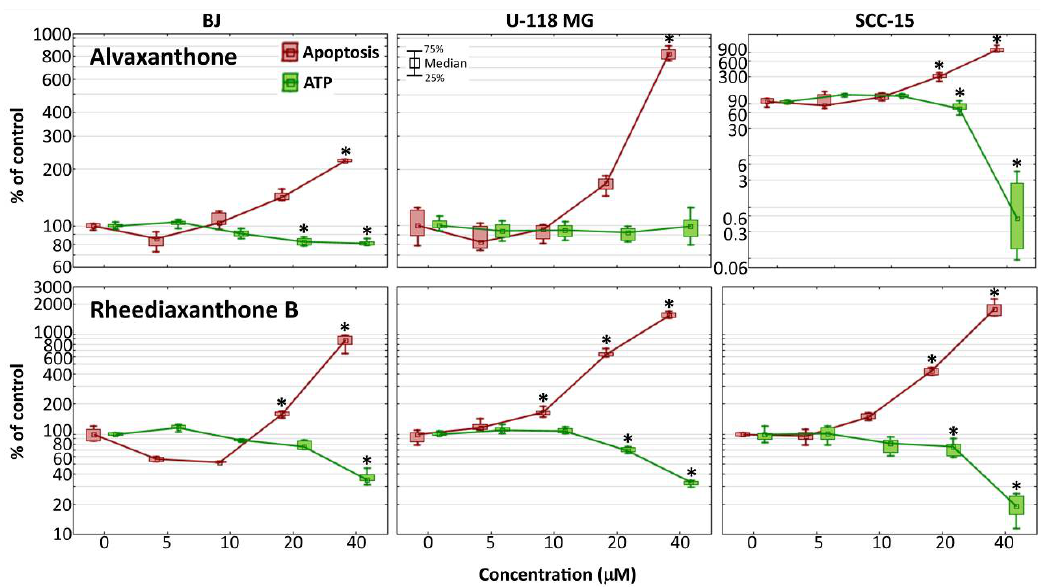
Figure 4. Changes of caspase-3/7 activities and intracellular ATP level in BJ, U-118 MG, and SCC-15 cells after 48-h incubation with 5–40 µM alvaxanthone or rheediaxanthone B. Median results are presented of three independent experiments, each performed in triplicate. The whiskers are lower (25%) and upper (75%) quartile ranges. The results significantly different from control (in view of the Kruskal–Wallis test) are indicated as * ( p ≤ 0.05).